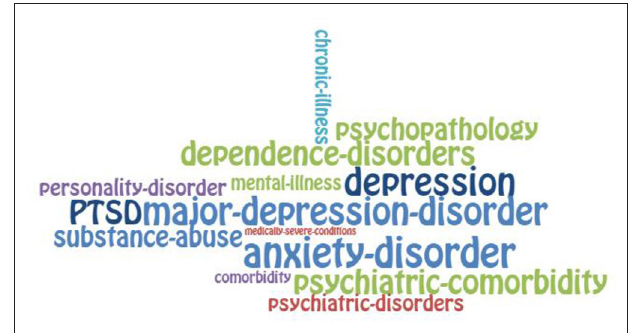
FIGURE 1 | State of suicidal mental pain: Diagnosis.